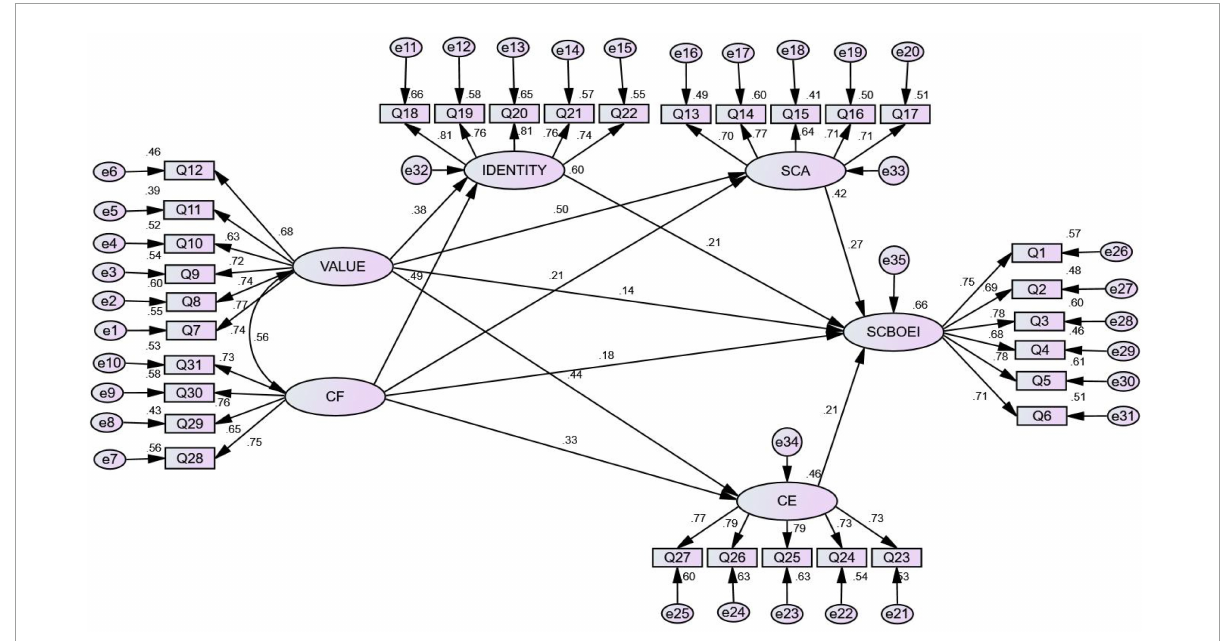
FIGURE2 Path analysis for the